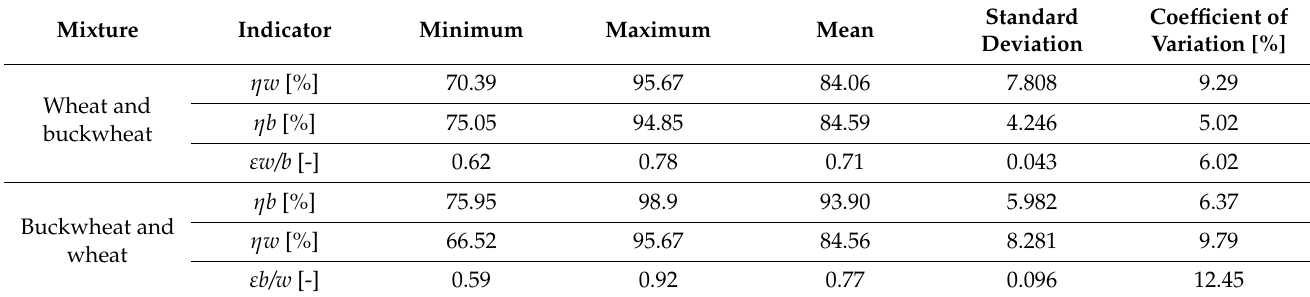
Table 1. Statistical parameters of the separation efficiency of seed mixtures.